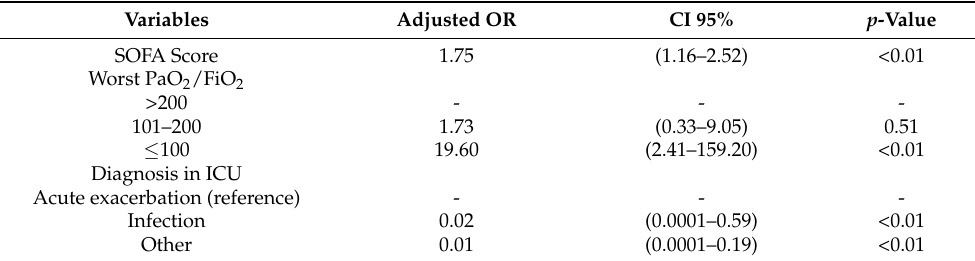
Table 4. Multivariate analysis to predict ICU mortality in SRD-ILD